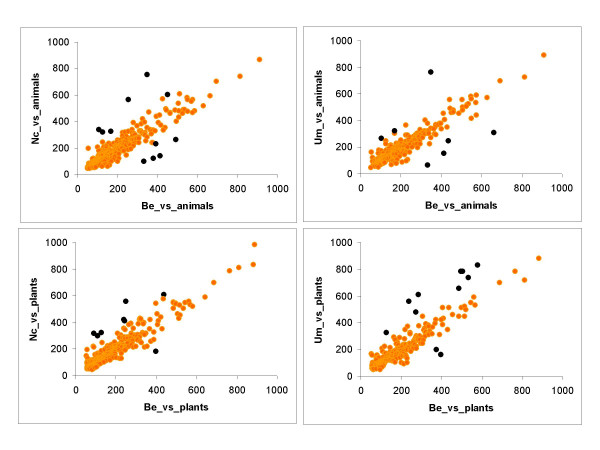
Pairwise score comparison between fungal orthologues and animal and plant sequences. Black dots on the plots represent score-pairs with a difference in bit score equal or higher than 150.